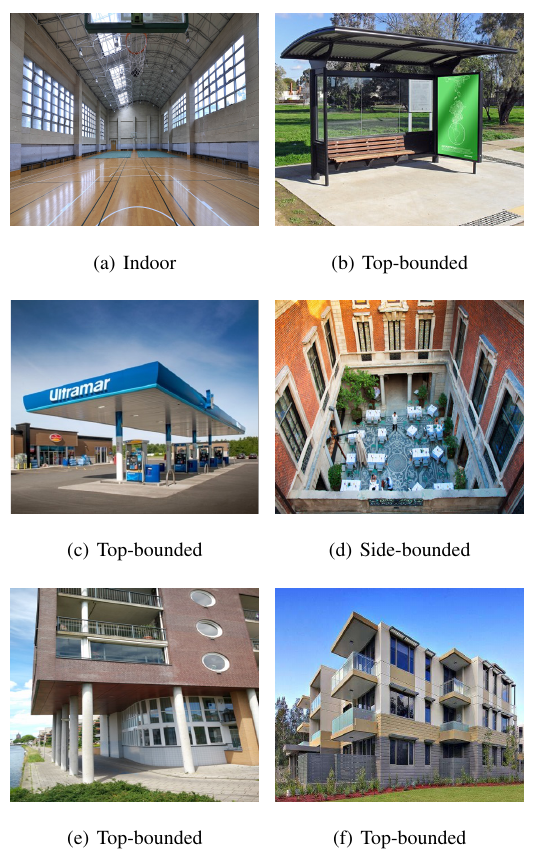
Figure 1. Examples of different environments (spaces) formed by buildings.